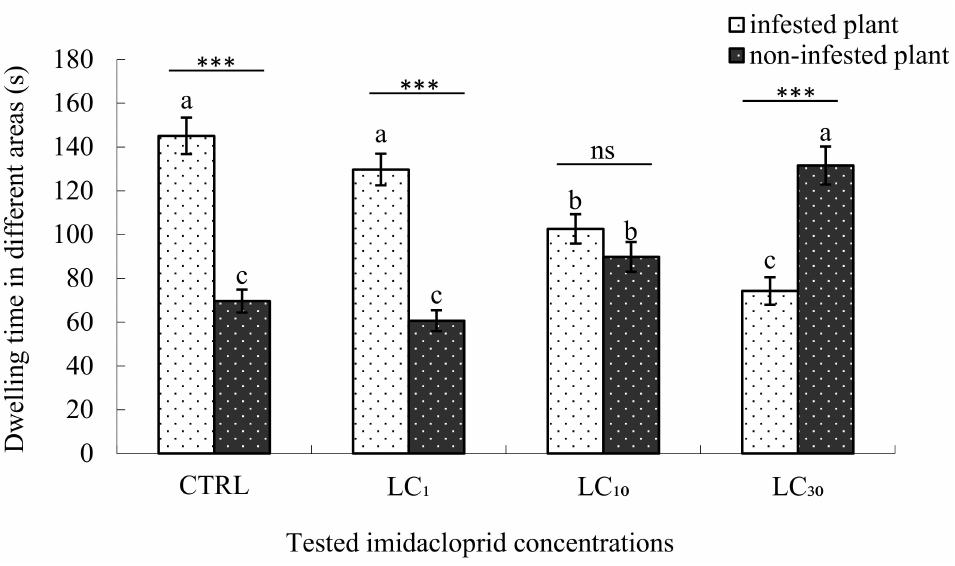
Figure 2. Dwelling time of Encarsia formosa in different areas treated with imidacloprid. Note: *** p < 0.001 (significantly different between the two groups, t -test), ns (not significantly different between the two groups, t -test). The same letter over the bars of infested plant or non-infested plant areas indicates no significant differences between the various concentrations (Duncan’s multiple range test, α < 0.05). The “infested plant area” means cotton plants in the four-armed olfactometer infested with 3rd or 4th instar B. tabaci nymphs, while the “non-infested plants” means healthy cotton plants without whitefly infestation in the four-armed